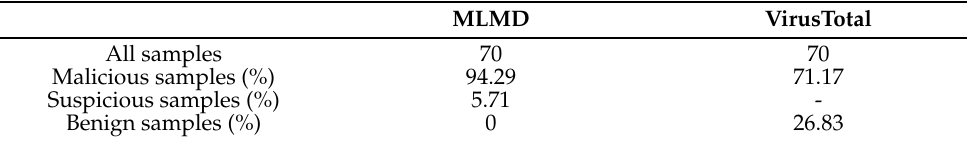
Table 17. Comparison of classifications of malicious samples.